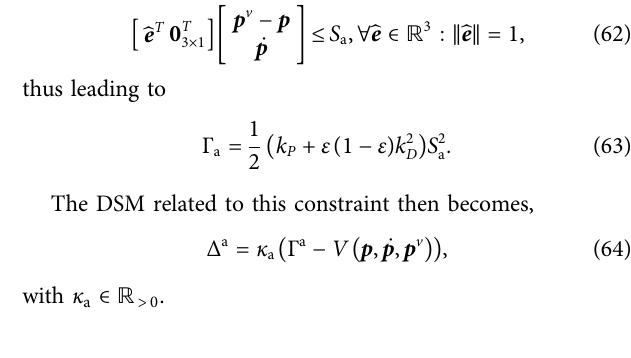
FIGURE7| Phaseplanerepresentationoftheproposedinputconstraint enforcementstrategies,illustratedforasecond-orderdynamicalsystem m € p (cid:2) T − mg subject to the pre-stabilizing control law T (cid:2) m ( k P ( p v − p ) − k D _ p + g ) with p v (cid:2) 0 and the input constraint T ≤ T max . The traditional Lyapunov based level-set (dark-grey) yields the most conservative DSM (47) . Aligning the level-set with the constraints (medium gray) by solving the of fl ine optimization problem (50) drastically increases the certi fi ed safe region (53) . Further improvements can be obtained by solving (54) and using the invariant set which is the set obtained after subtracting the intersection between the light-grey Lyapunov level set and the region violating the input constraint from the light-grey Lyapunov level set. All three sets are certi fi ably safe since the fl owvectorsoftheclosed-loopsystem(inblue)allpointinward.Notethat,due to the high values in the fi rst block diagonal of (17) , any constraint that only depends on the position error variables, e.g. of the form p (cid:2) a with a ∈ R , is already very well aligned under the traditional strategy. Hence, performance bene fi ts from optimal alignment are marginal.